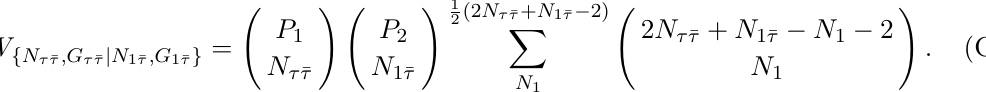
) and 1(cid:22) (cid:28) ( ) are real anyons in the bulk. Our convention (cid:15) (cid:12)